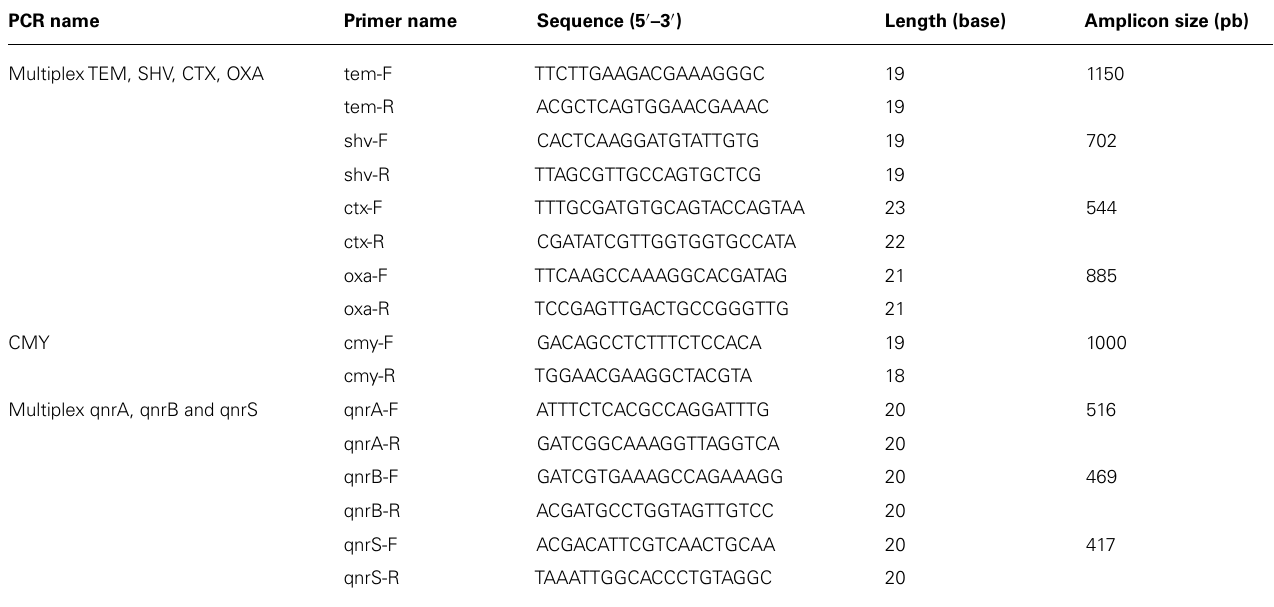
Table 1 | Specific group primers used for PCR assays for beta-lactamase and qnr